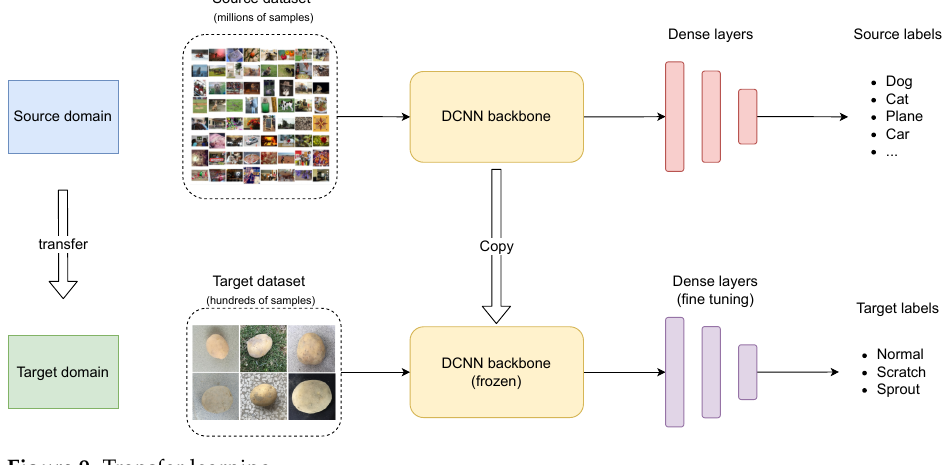
Figure 9. Transfer